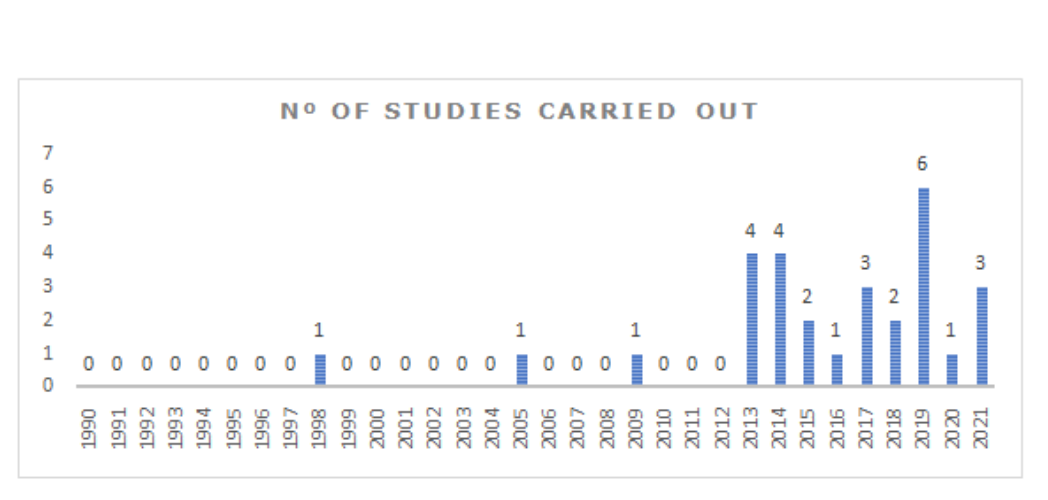
Figure 4. Research on the supply chain of the cement industry between 1990 and 2021